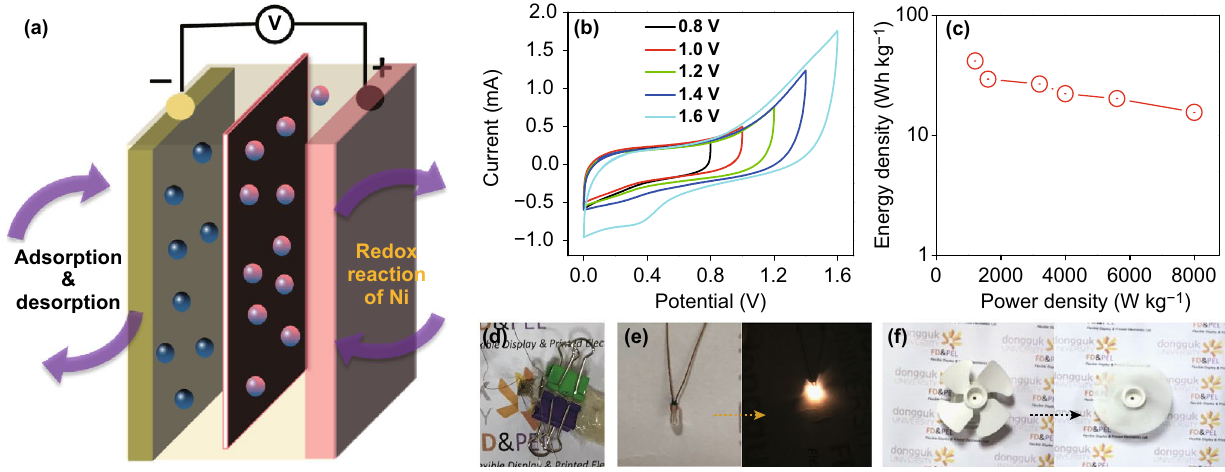
Fig. 11 a Schematic diagram of the assembled asymmetric solid‑state device. b CV voltammograms of the assembled device at various poten‑ tials. c Ragone plot of the solid‑state device. d Picture of the assembled device. e , f Illumination of the LEDs and fan powered by the assembled